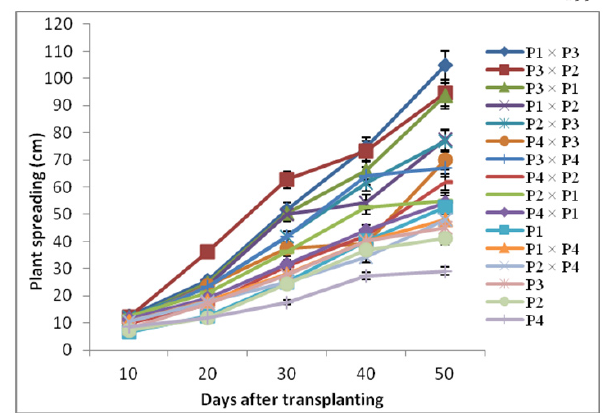
Fig. 2. The trend of increasing in plant spreading of parents and